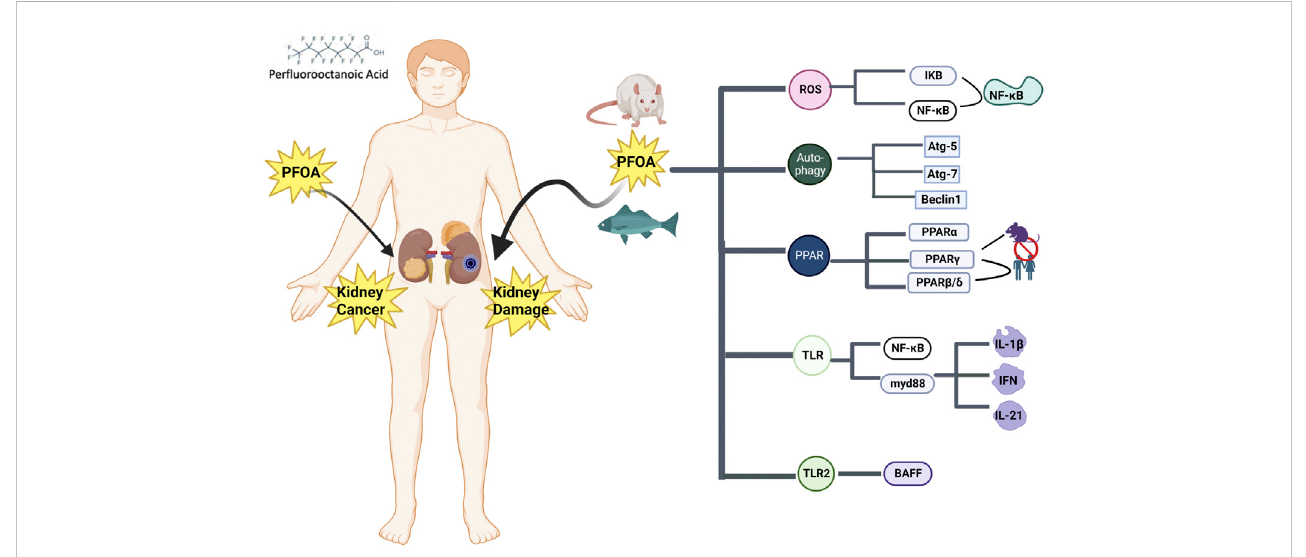
FIGURE 3 Effects of per fl uorooctanoic acid on the kidneys and mediated